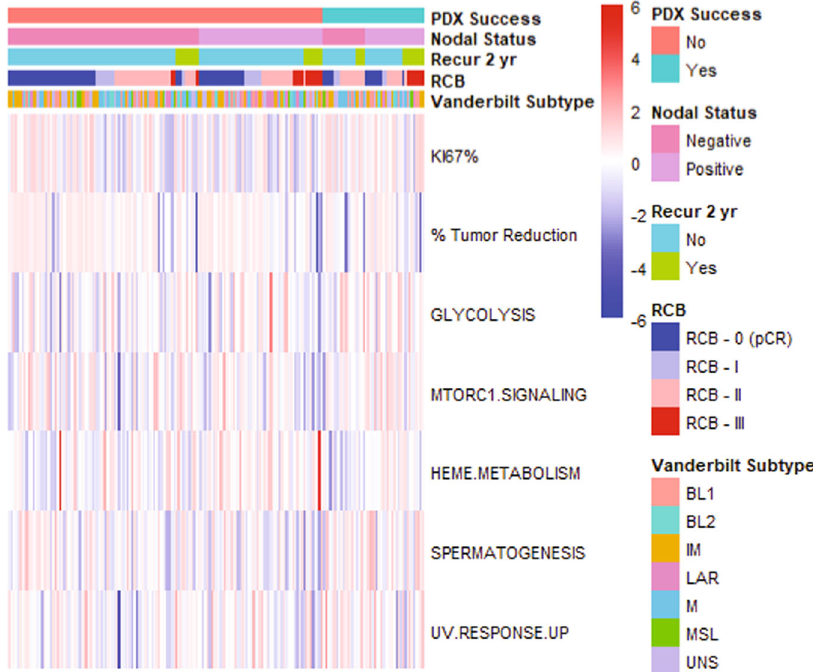
Fig. 3 Continuous variables associated with PDX success. Continuous variables associated with PDX success are included in this